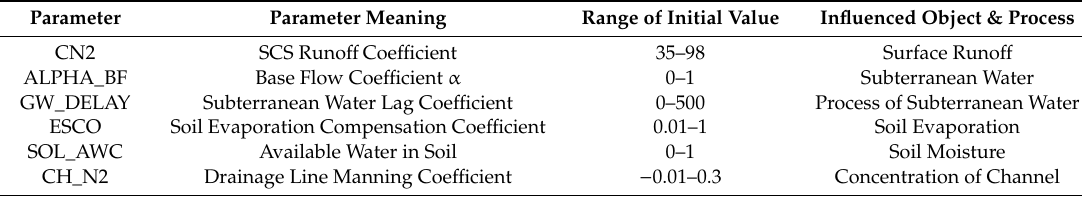
Table 3. Sensitivity parameter and value range of the Xinxue River drainage basin.